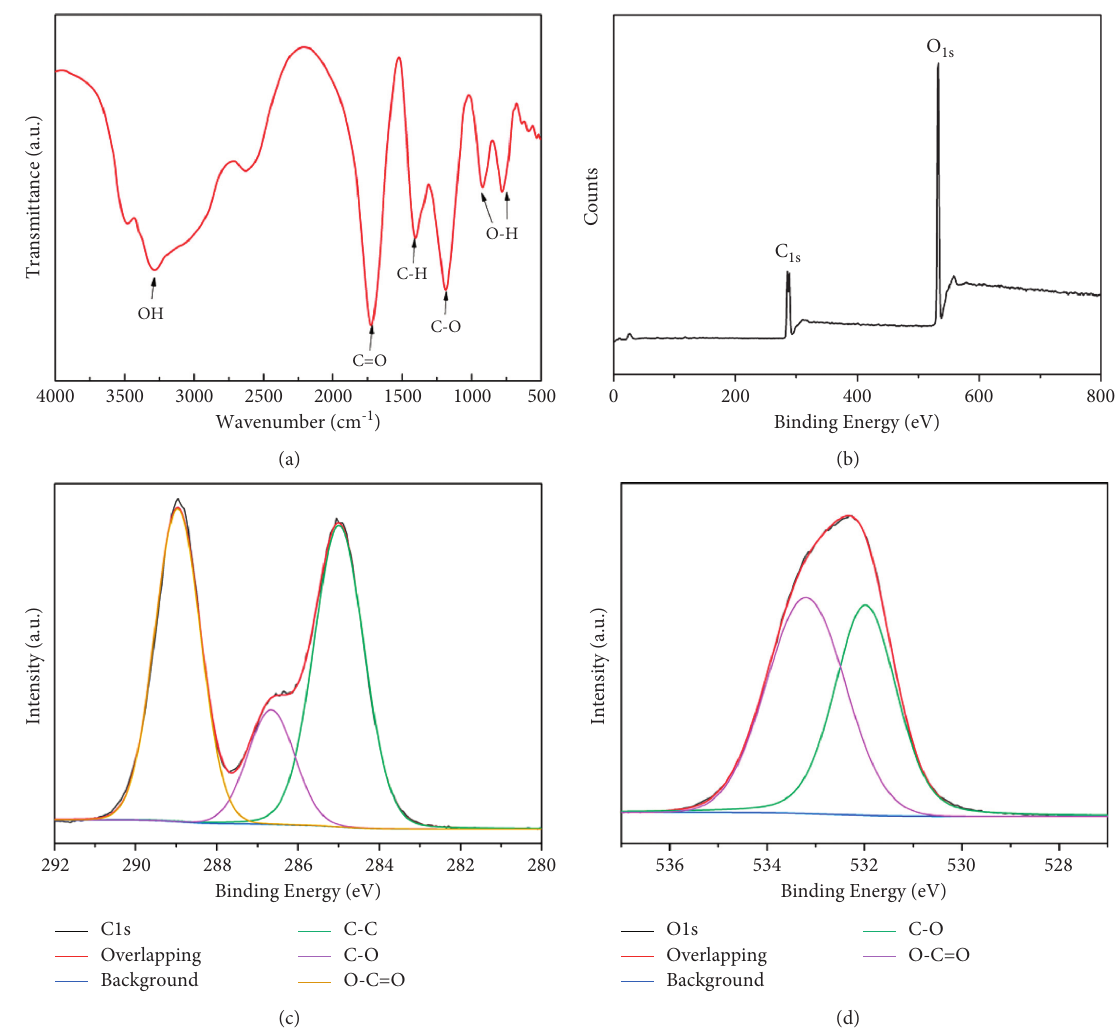
Figure 3: (a) FT-IR spectra of the CDs. (b) XPS survey of CDs. The high resolution of C 1s (c) and O 1s (d) spectra of the CDs.